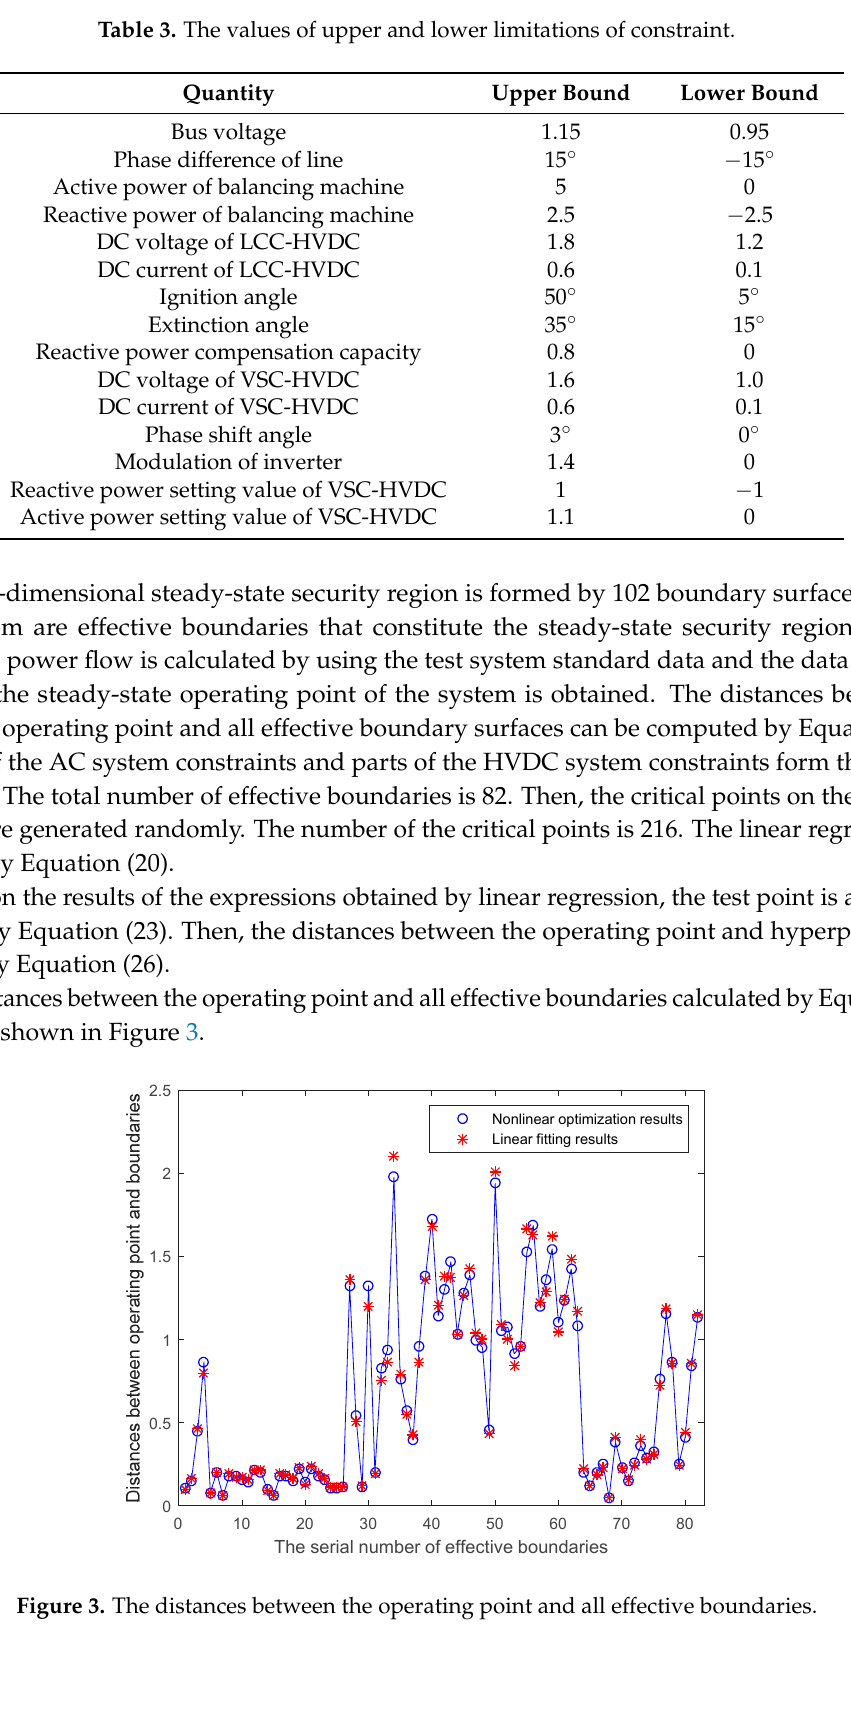
Table 3. The values of upper and lower limitations of constraint.